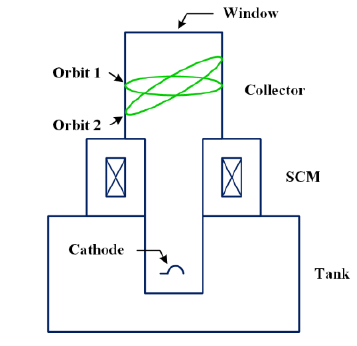
Fig. 4. Diagram of poor and good magnet alignment.